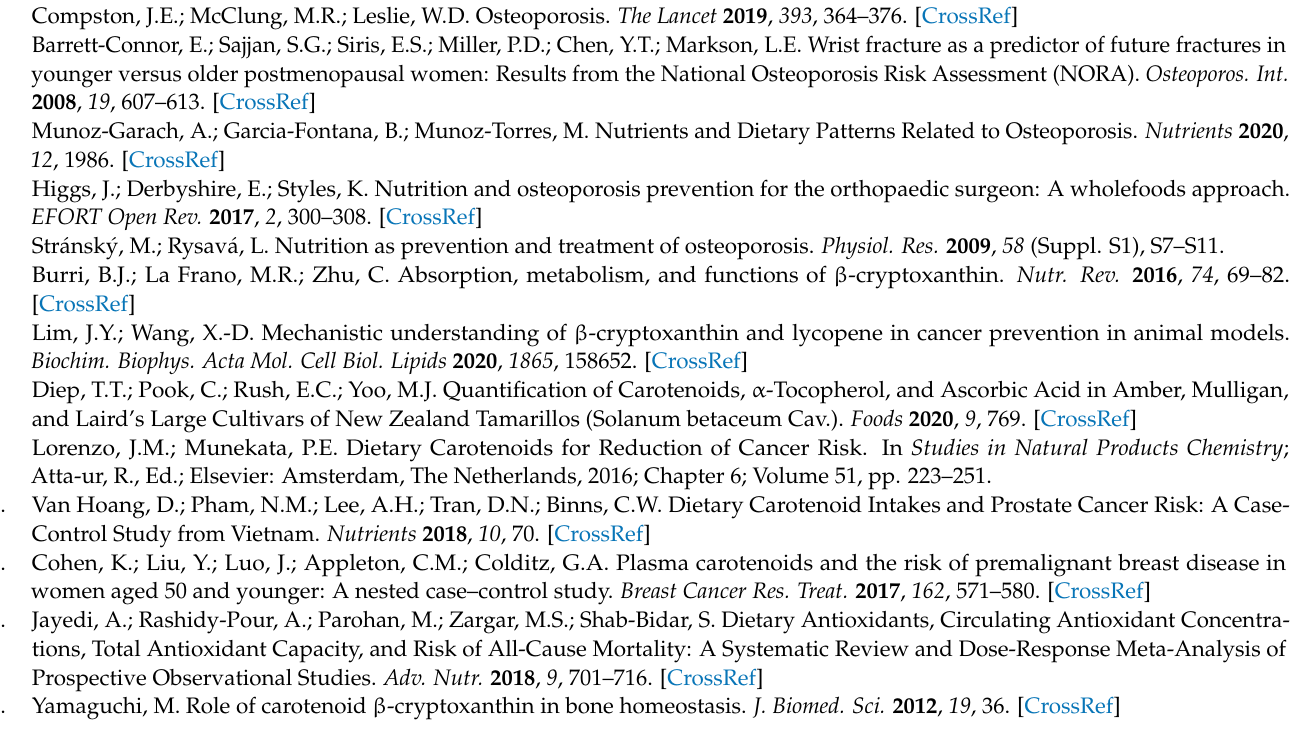
(MOOSE) Checklist, Table S2: Quality assessment table of the included cohort and cross-sectional studies, Table S3: Quality assessment table of the included case-control studies, Table S4: Details of variable adjustment factors of the included